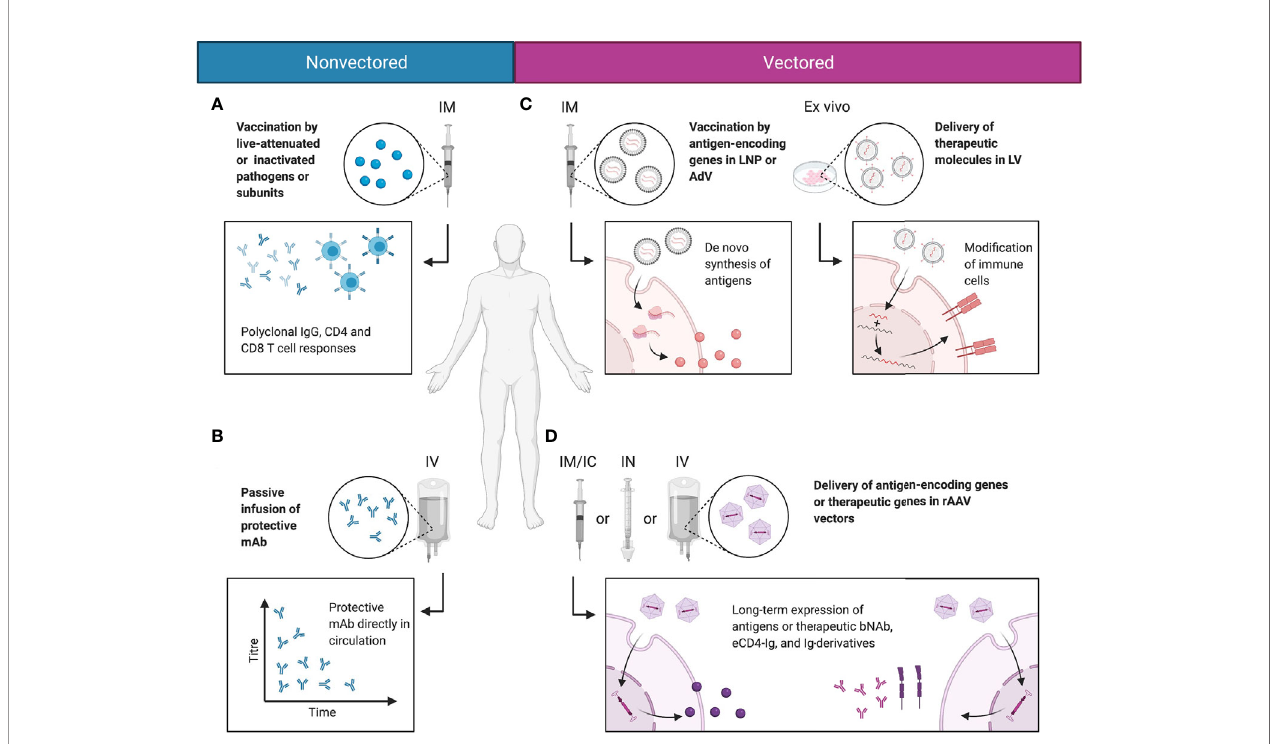
FIGURE 2 | Comparisons between non-vectored and vectored immunotherapeutic strategies. (A) Most vaccines today function by delivering antigen in the form of live-attenuated or inactivated pathogens or antigen subunits. This induces polyclonal humoral and cellular responses and immunological memory that protect the host from infections. (B) In rapidly mutating pathogens that evade normal vaccine-induced immunity, protective mAbs may be directly delivered to the blood stream via passive infusion to mediate protective function. (C) Alternatively, genetic material may be delivered in LNPs or viral vectors, such as AdV or LV. This mediates de novo synthesis of the antigen in the natural conformation, or allows the modi fi cation of immune cells into stronger effector cells. (D) rAAV vectors deliver the genetic material of the encoded antigen or therapeutic molecule putatively to the nucleus, as persistent episomes for gene expression. This enables long-term expression of the antigen or therapeutic molecule in a native conformation and topology, and reduces the need for drug redosing. Created with